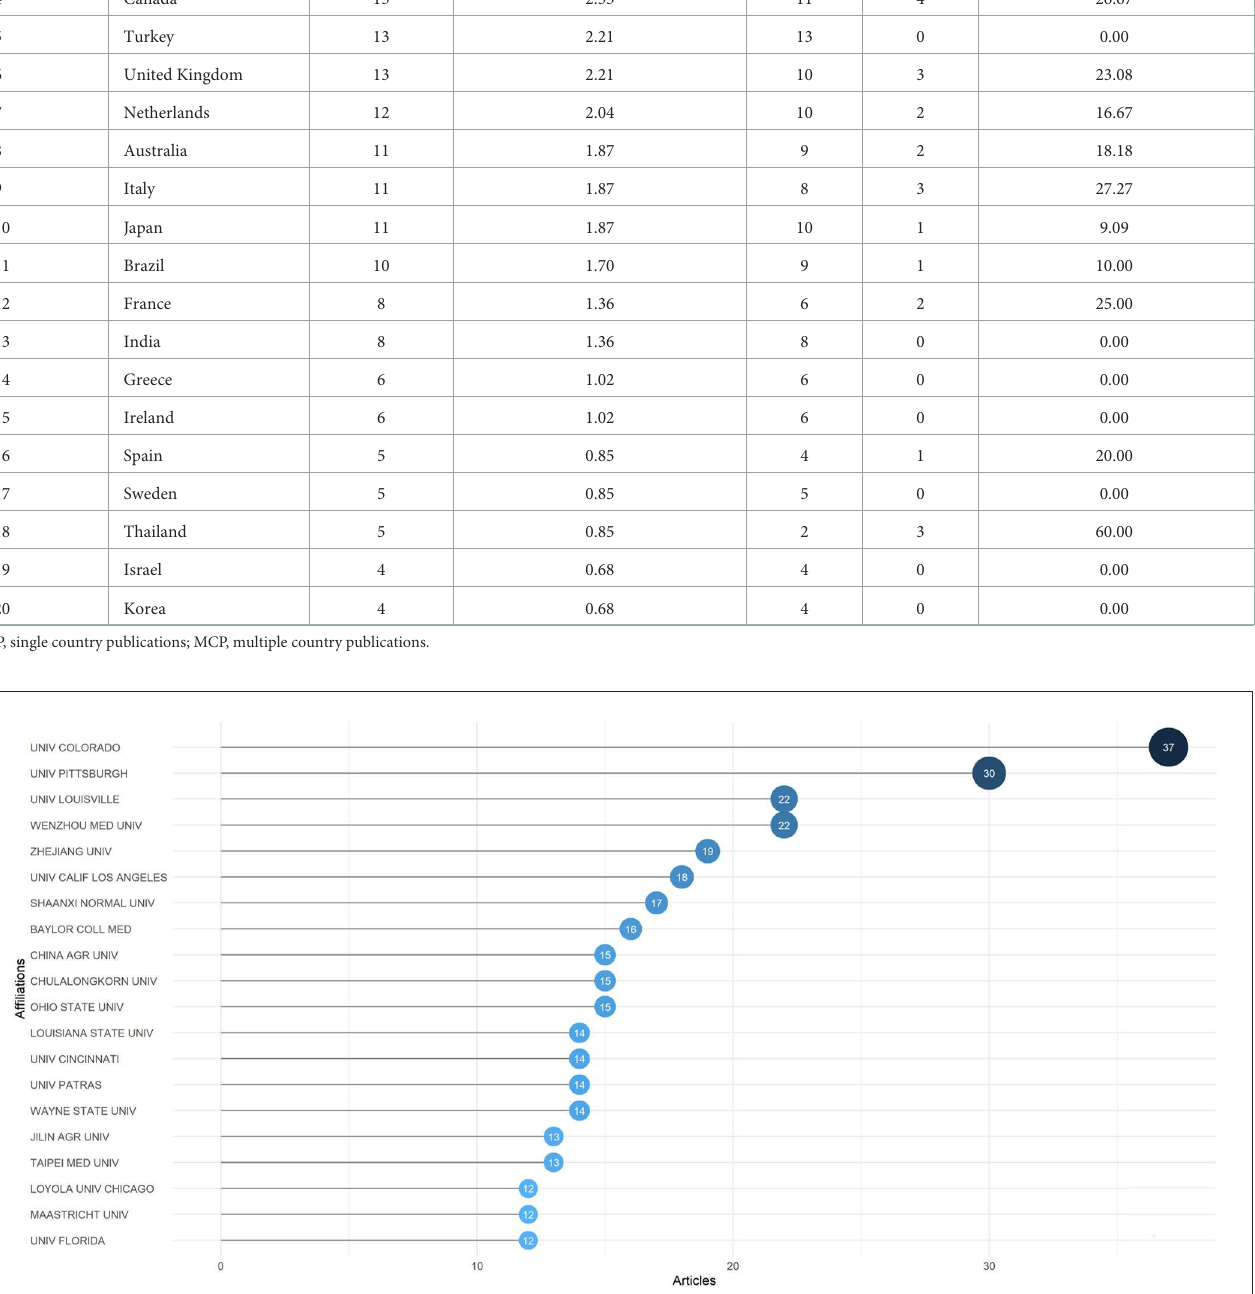
Food & Function ( n = 33) was the most prolific journal, followed by Journal of Trauma-Injury Infection and Critical Care ( n = 32), Scientific Reports ( n = 24), PLoS ONE ( n = 18) and Shock ( n =